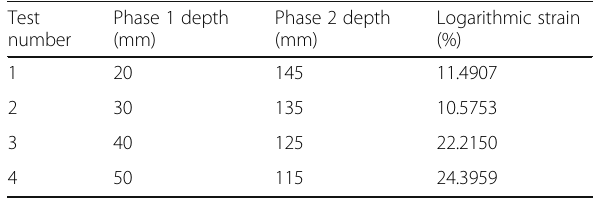
Table 9 Trial and error related to dividing the submergence depth between the two phases and the logarithmic strain